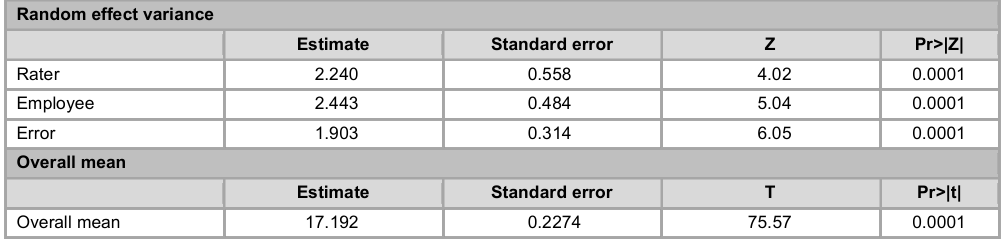
The parameters estimate from fitting raters’ effect as a random